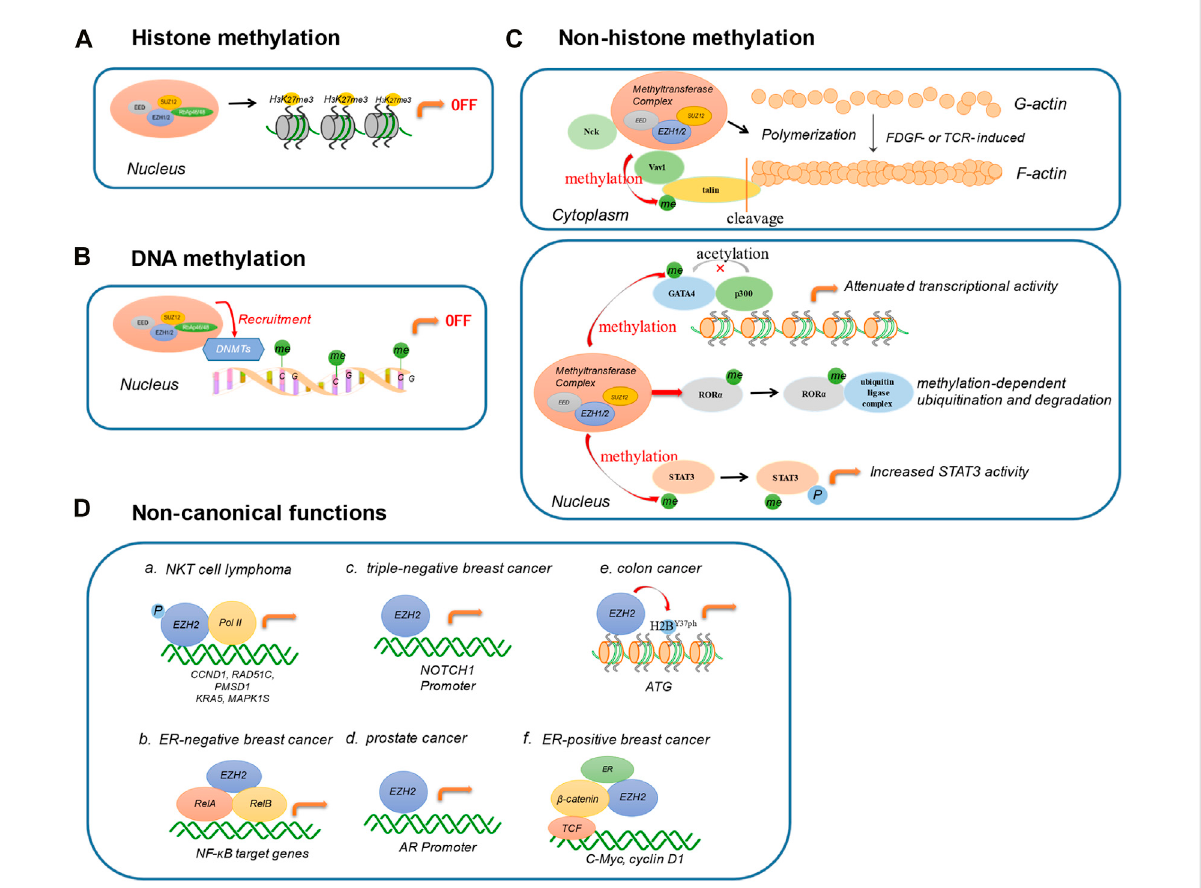
FIGURE 2 Biological functions ofEZH2. (A) Histone methylation. EZH2 catalyzesthelysine trimethylationof histone 3atposition27. (B) DNAmethylation. EZH2 directly controls DNA methylation via recruiting DNA methyltransferases (DNMTs). (C) Non-histone methylation. EZH2 regulates cell migration, invasion,and adhesionbymediating themethylationofcytoplasmicproteins,includingVav1,Nck,andtalin. Inthenucleus, EZH2canalso methylate transcription factors for diverse functions, such as GATA4, ROR α , and STAT3. (D) Non-canonical functions. EZH2 exerts non- canonicalfunctionsinaPRC2-independentcomplex.a.InNKTcelllymphoma,thephosphorylationofEZH2directlybindswithPolIIinvolvedinDNA replication, cell cycle, biosynthesis, stemness, and invasiveness. b. In ER-negative breast cancer, EZH2 interacts with RelA/RelB to promote the expression of NF- κ B targets. c. In triple-negative breast cancer, EZH2 activates NOTCH1 signaling by directly binding to NOTCH1 promoter.